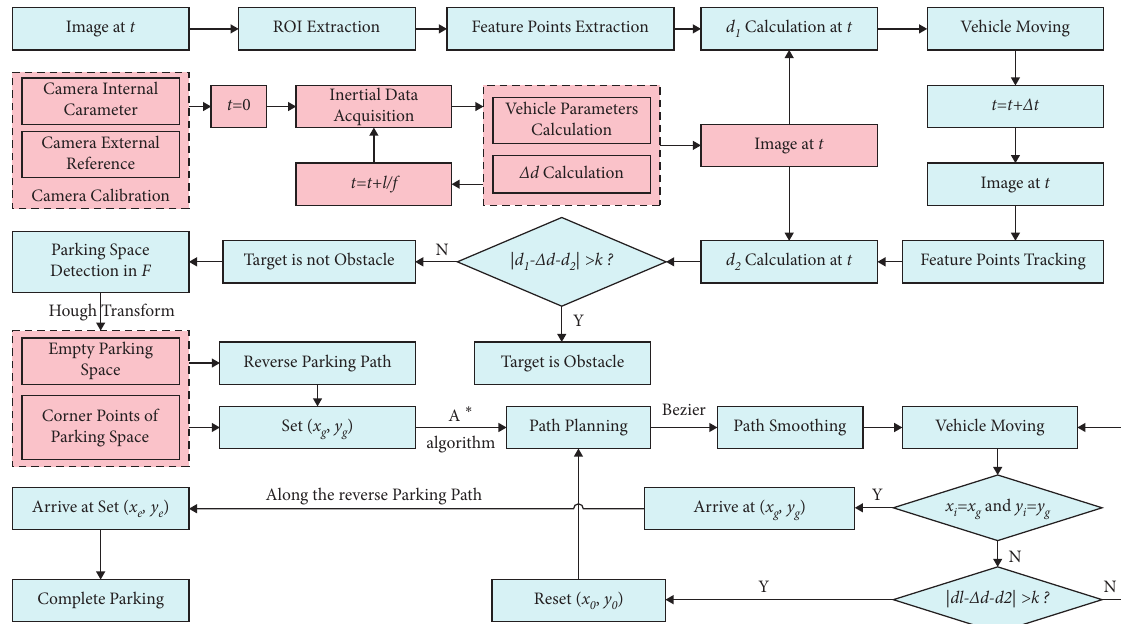
Figure 14: Flowchart of parking space detection and path planning based on